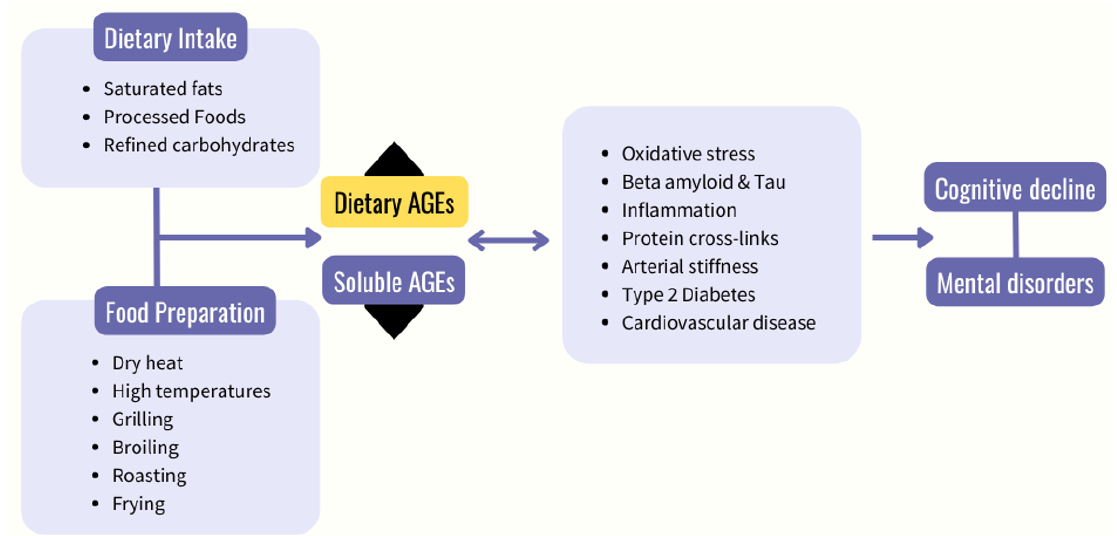
Figure 2. Proposed pathway through which dietary AGEs contribute to cognitive decline and mental disorders. Black arrow pointing up indicates an increase in dietary advanced glycation end products (AGEs), and black arrow pointing down indicates a decrease in soluble AGEs.